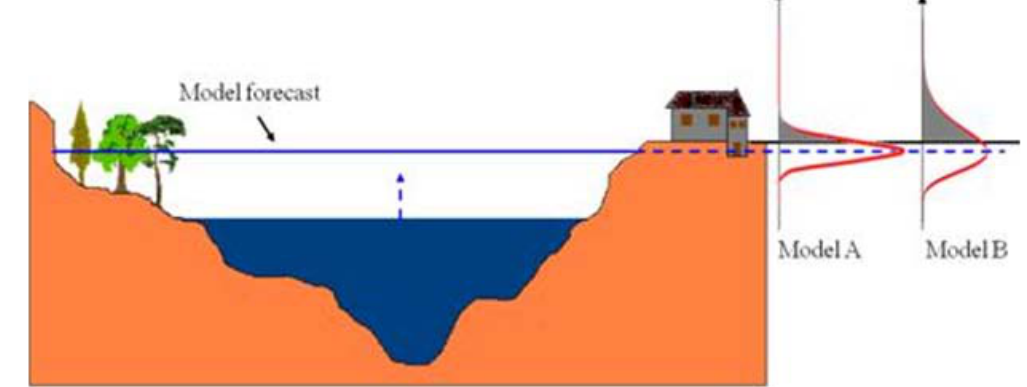
Fig. 1. Probability of exceeding the dyke level for the same expected value, forecasted by models with different reliability.